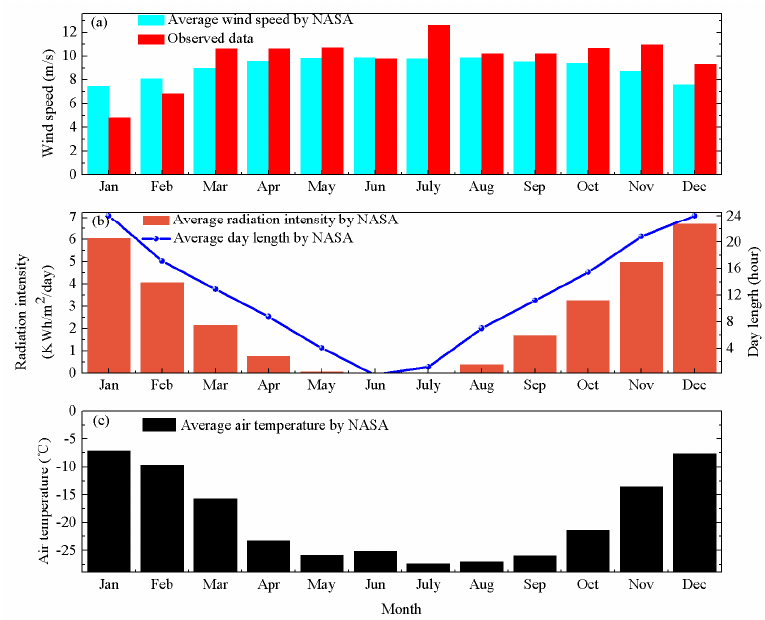
Figure 2. The monthly meteorological data of Zhongshan Station. ( a ) wind speed, ( b ) solar radiation and day length, ( c ) air temperature.